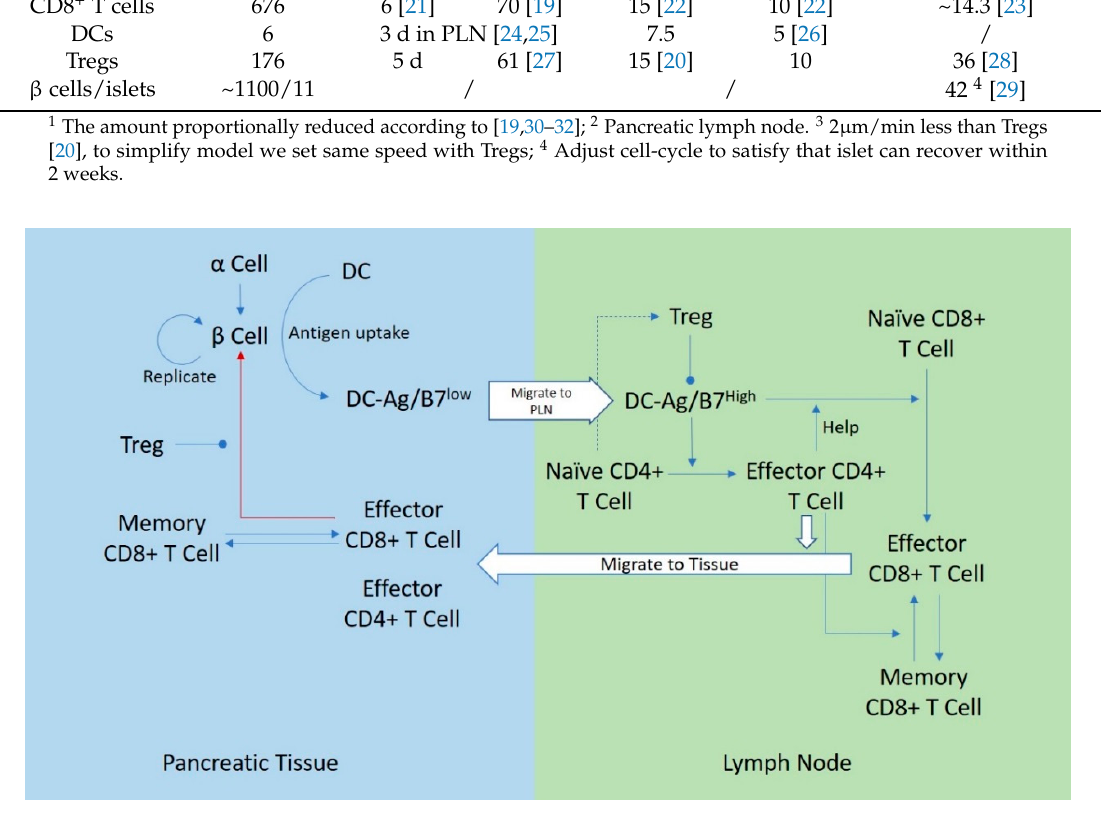
Figure 2. Schematic diagram of cell interactions in pancreatic lymph node (PLN) and pancreatic tissue